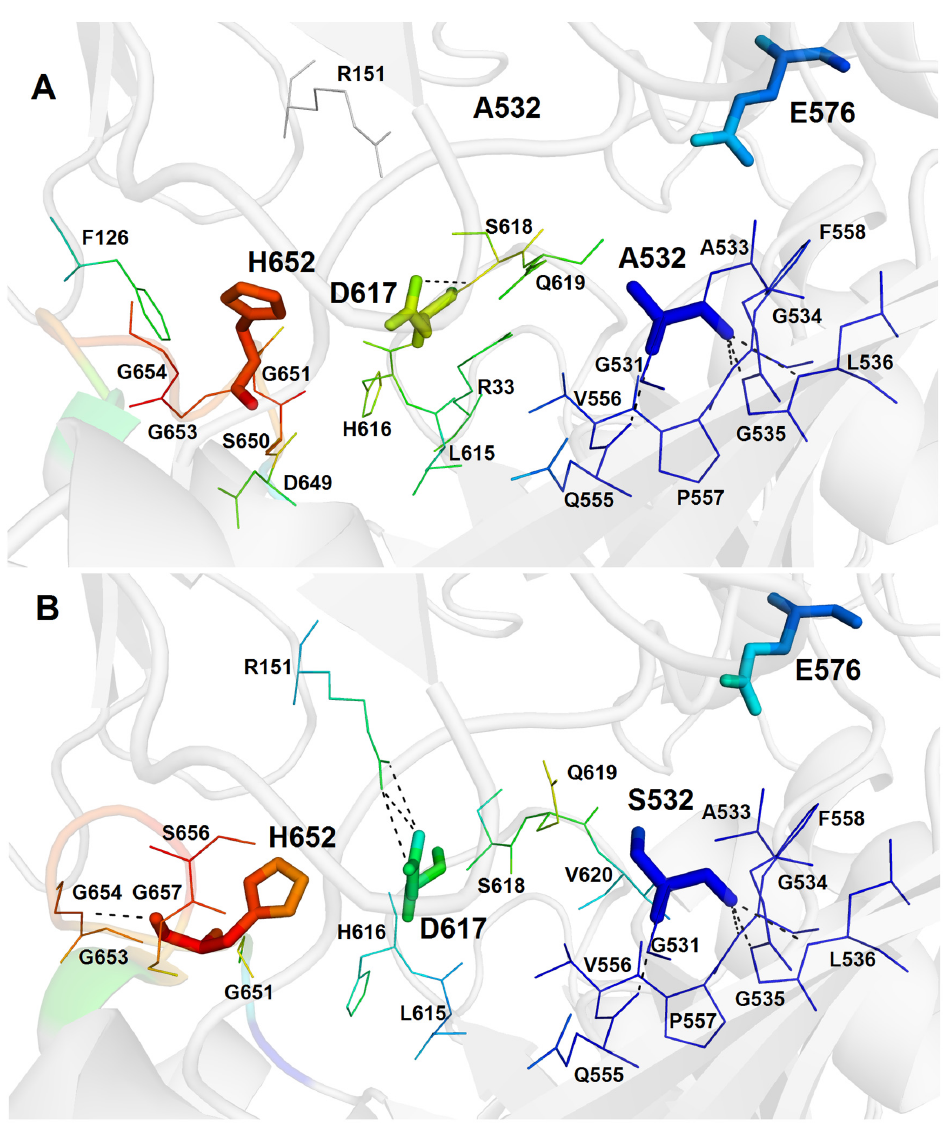
Figure 3. The catalytic triad arrangement in the 4 Å radius in the SpOPBS532A ( A ) and SpOPBmod (7YWS) ( B ) structures. All residues are shown with sticks and are colored according to their B-factor values. The E576 residues of the S1 substrate-binding center and the catalytic triad residues are enlarged. The polar contacts are shown by dotted lines. The comparison of the original hinge peptide (IPQQEH) in the SpOPBS532A struc ‐ ture and the modified one (ENLYFQ) in the SpOPBmod structure (7YWS) is shown in Figure 4. The intact and modified variants had a similar composition of aliphatic, charged, and polar residues but a different order of the charge distribution. In both cases (independently from the modification), the main chains of the hinge peptides were sta ‐ bilized by polar contacts with the adjacent areas of the catalytic and β‐ propeller domains, and with the second hinge peptide including the I/E71N ‐ V68O, E/F75O ‐ F91N, H/Q76O ‐ K402NZ, I/E71O ‐ K407NZ interactions, respectively. In addition, F75 from the modified hinge interacted with F91 through both the main chains (F75N ‐ F91O) and phenyl rings of the side chains. The residues L73 and Y74 from the modified hinge were